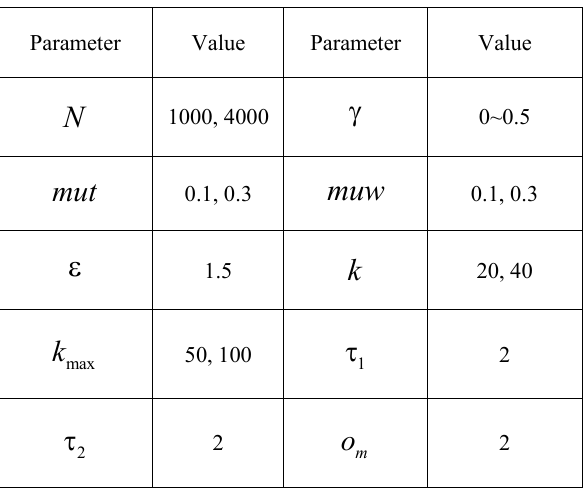
Table 1. Parameter Settings in